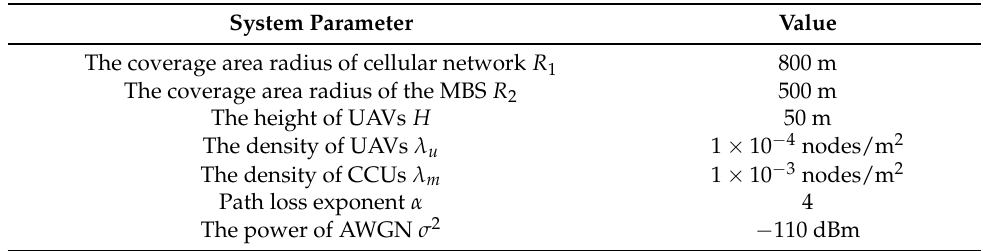
Table 1. Defalut System Parameters Settings. System Parameter Value The coverage area radius of cellular network R